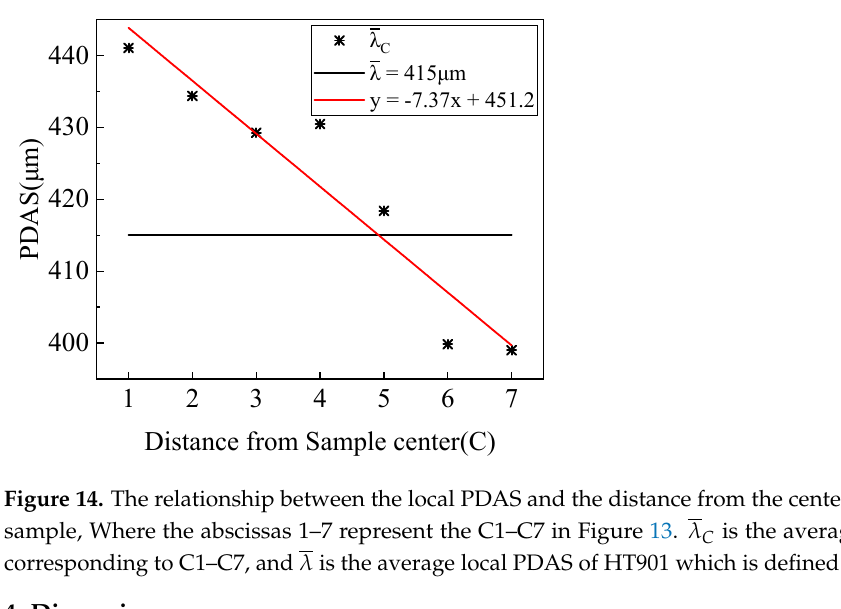
Figure 13. The 7 rings which are equally spaced from the local PDAS distribution of HT901; C1 is the center of HT901, and C7 is the edge of the sample.